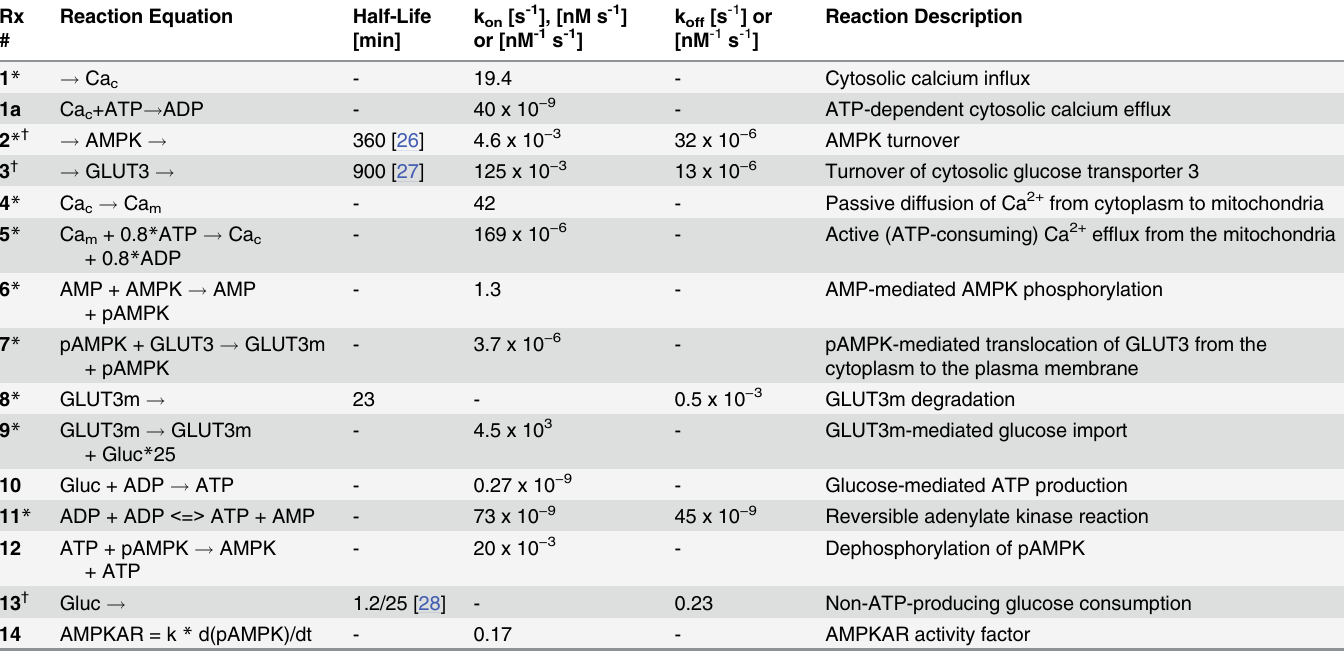
Table 2. Reaction (Rx) equations and kinetic flux values for the modelled reaction